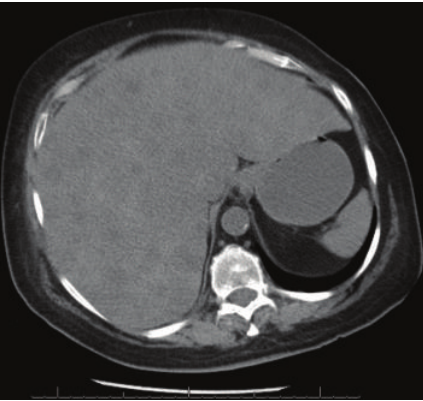
Figure 2: CT of the abdomen without contrast showed markedly enlarged abnormal heterogeneous liver.